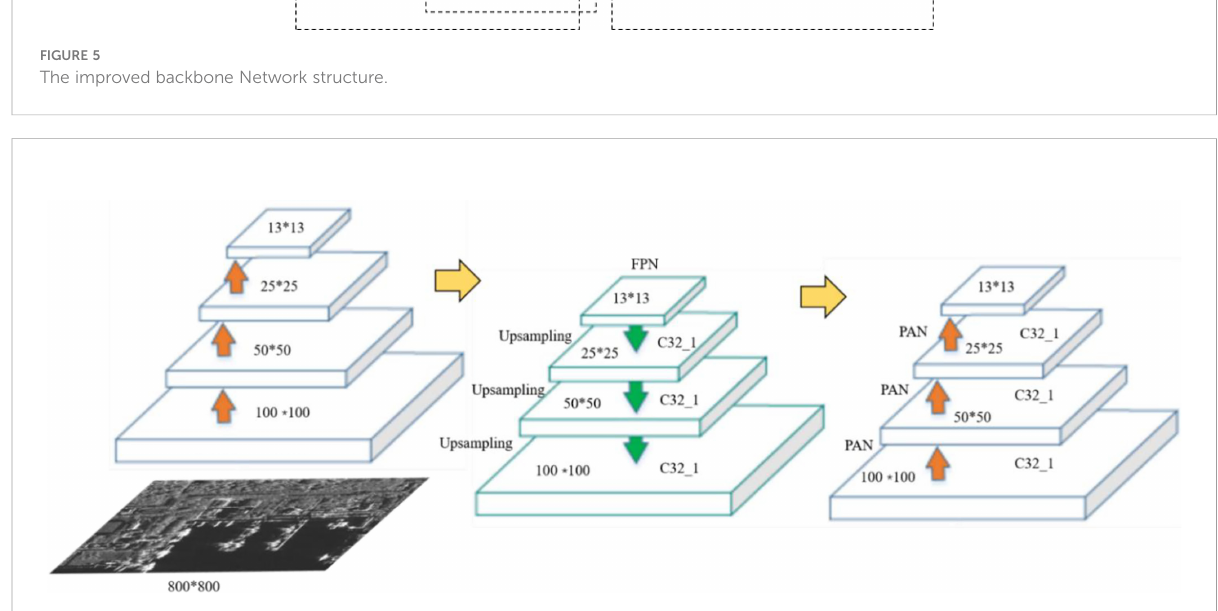
FIGURE 6 Improved FPN + PAN structure.